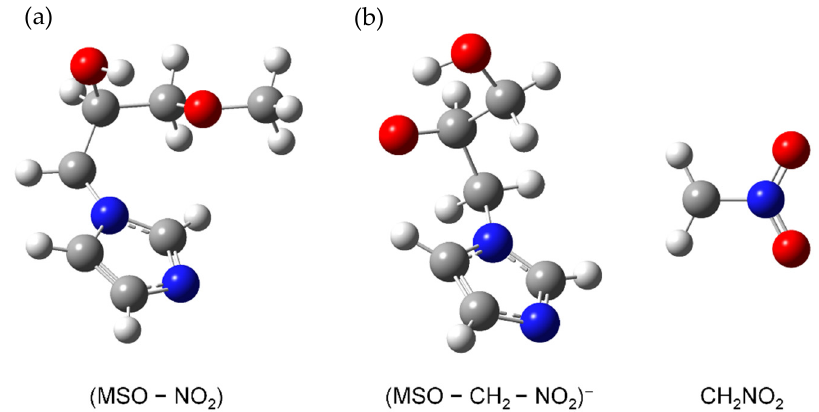
Figure 6. ( a ) Calculated structure of the neutral product of the DEA Reaction (1). ( b ) Calculated structure of the charged and neutral products of the DEA Reaction (3).